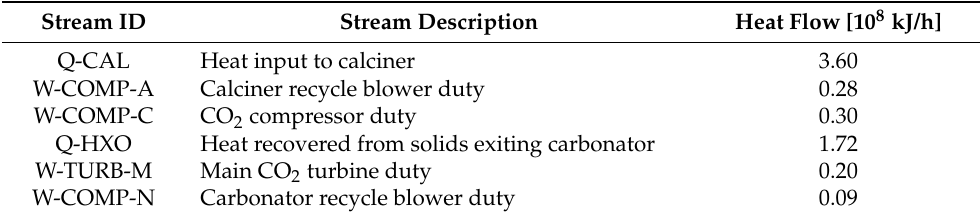
Table A4. Configuration 2 base case energy input and recovery